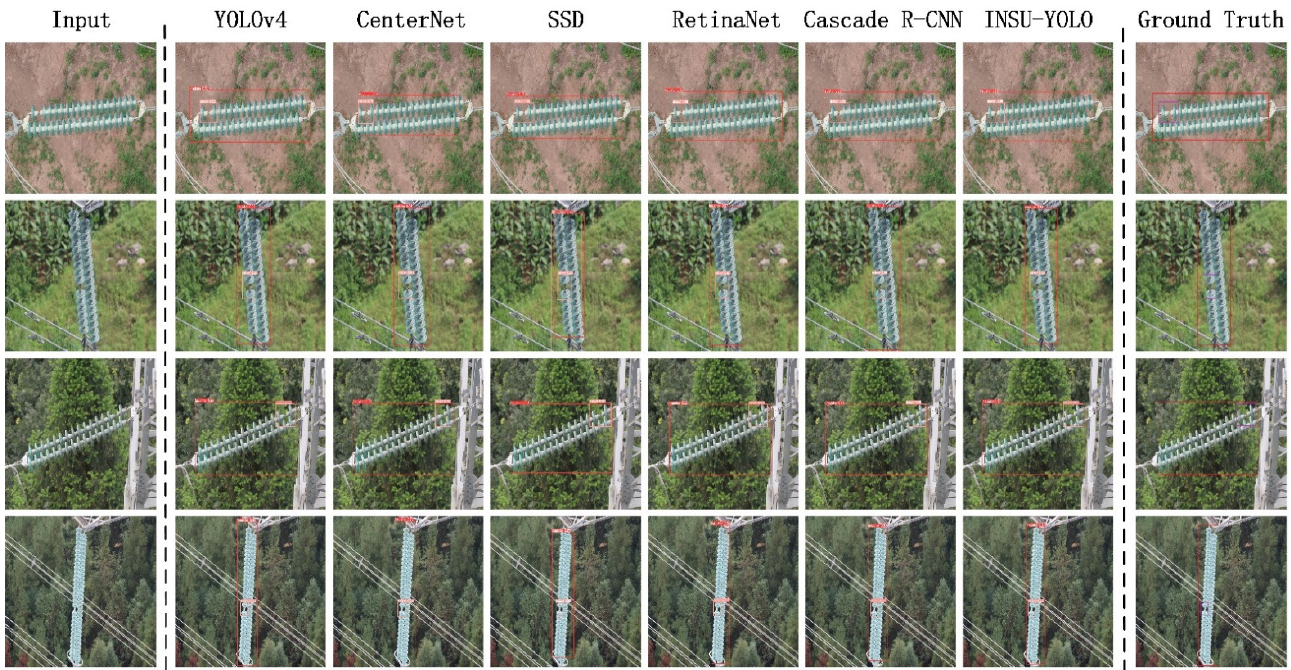
Figure 7. Test examples of each model on the InsuDetSet dataset. Experimental results show that the performance of INSU-YOLO is similar to Cascade R-CNN, better than SSD, RetinaNet and YOLOv4 in one-stage class, and CenterNet based on heatmap.